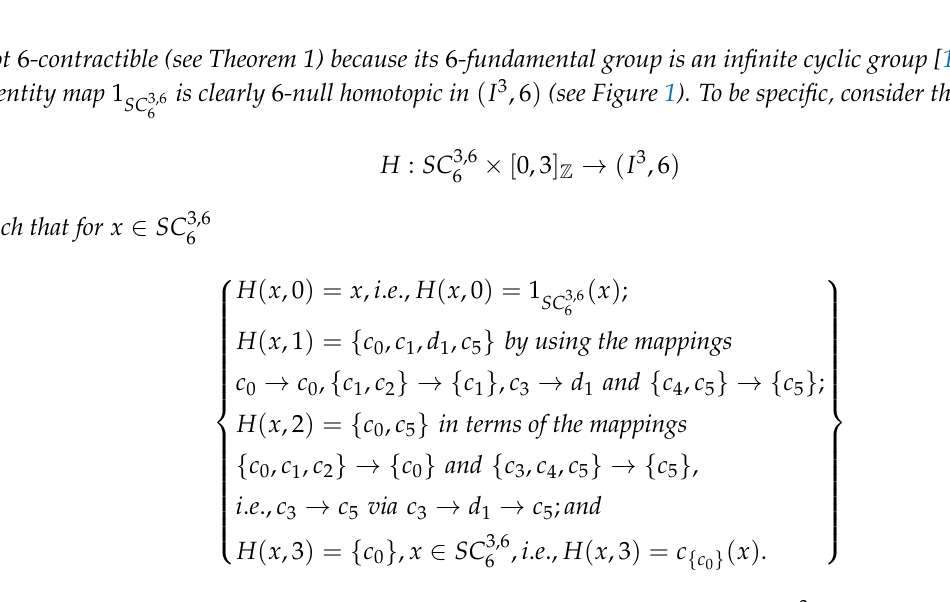
in ( I 3 ,6 ) SC 3,6 6